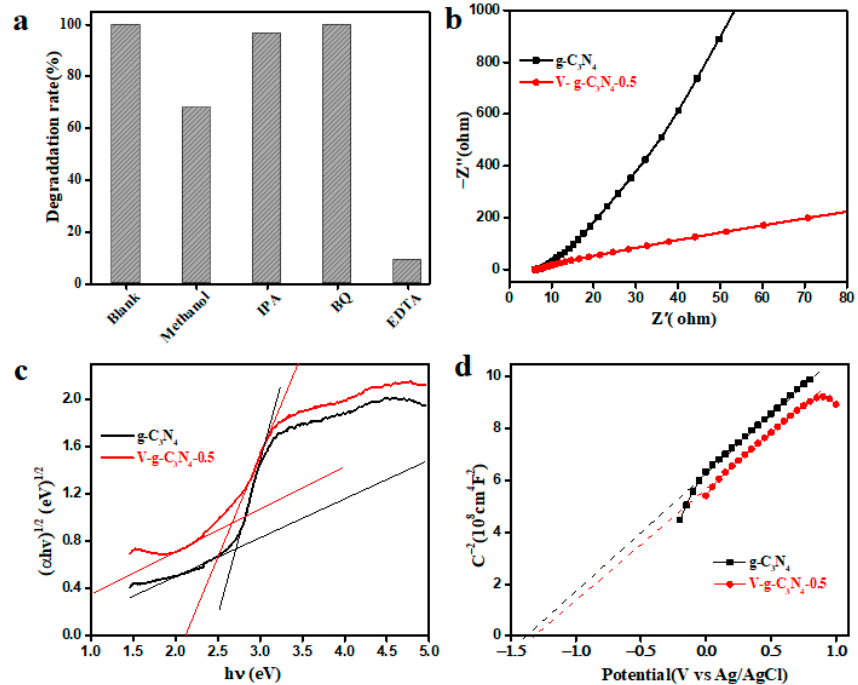
Figure 10. The results of reactive species scavengers ( a ); EIS curves ( b ), Tauc plots ( c ), and Mott ‐ Schottky curves ( d ).